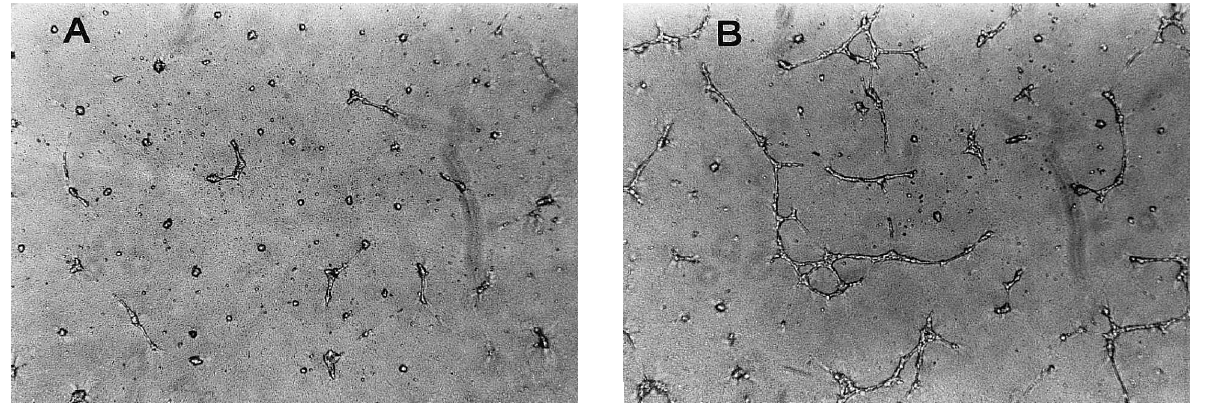
FIG. 1. Tube formation in Matrigel by HUVEC cells in the absence (A) or in the presence (B) of bFGF (20ng/ml).